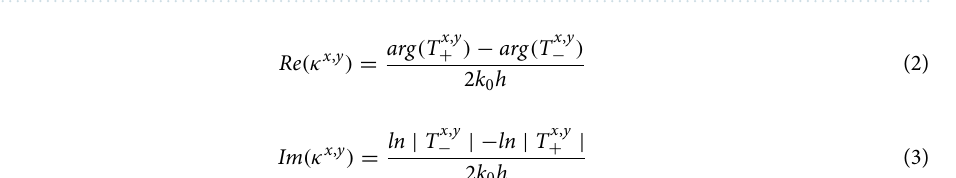
Figure 5. Transmission parameters ( a ) -z-direction ( b )